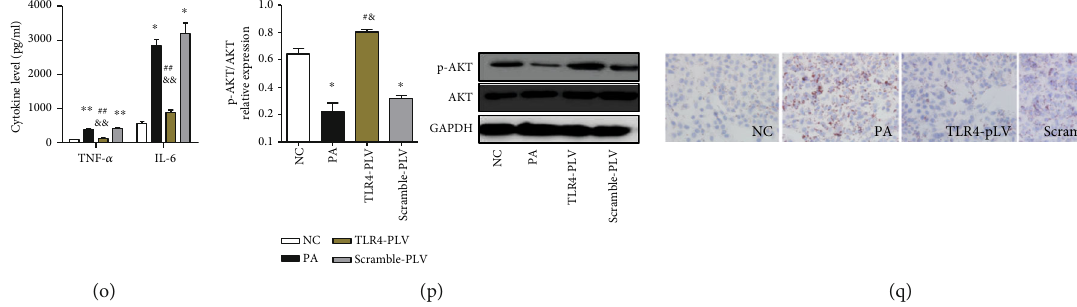
Figure 3: TLR4 siRNA transfection mitigated PA-induced in fl ammation in RAW264.7 cells and metabolic abnormalities in cocultured AML hepatocytes. The expressions of proin fl ammatory macrophage (M1 type) speci fi c surface marker CD11c and proin fl ammatory factors (IL-1 β , IL-6, and TNF- α ) were signi fi cantly increased, while the expressions of anti-in fl ammatory macrophage (M2 type) speci fi c surface marker CD206 and anti-in fl ammatory factor IL-10 were obviously decreased in palmitic acid- (PA-) treated RAW264.7 cells (a). PA treatment promoted the expression of TLR4 mRNA and protein and Ikk β /NF- κ B, activation of JNK/AP1 pathway in RAW264.7 cells, and production of proin fl ammatory factors (TNF- α and IL-6) in the supernatant (b – d). The phosphorylation of AKT was signi fi cantly decreased, and intracellular lipid accumulation was signi fi cantly increased in cocultured AML12 hepatocytes (e, f). TLR4 transfection signi fi cantly downregulated the TLR4 mRNA expression in RAW264.7 macrophages (g, j). TLR4 siRNA transfection mitigated PA- induced augmentation in JNK phosphorylation (k). TLR4 siRNA transfection could attenuate PA-induced increases in the mRNA expression and DNA binding activity of AP1 and NF- κ B (l, m), as well as proin fl ammatory factor (IL-1 β , IL-6, and TNF- α ) expression in RAW264.7 macrophages and TNF- α and IL-6 levels in the supernatant (n, o). TLR4 siRNA transfection alleviated PA-induced decreases in the mRNA expression of IL-10 (n). TLR4 siRNA transfection in RAW264.7 macrophages signi fi cantly ameliorated the decreases in AKT phosphorylation and lipid accumulation in cocultured AML12 hepatocytes (p, q). Data are presented as mean ± SEM ; ∗ p < 0 : 05 and ∗∗ p < 0 : 01 compared with the NC group; & p < 0 : 05 and && p < 0 : 01 compared with the Scramble-pLV group (j – n); # p < 0 : 05 and ## p < 0 : 01 compared with the PA group (k –